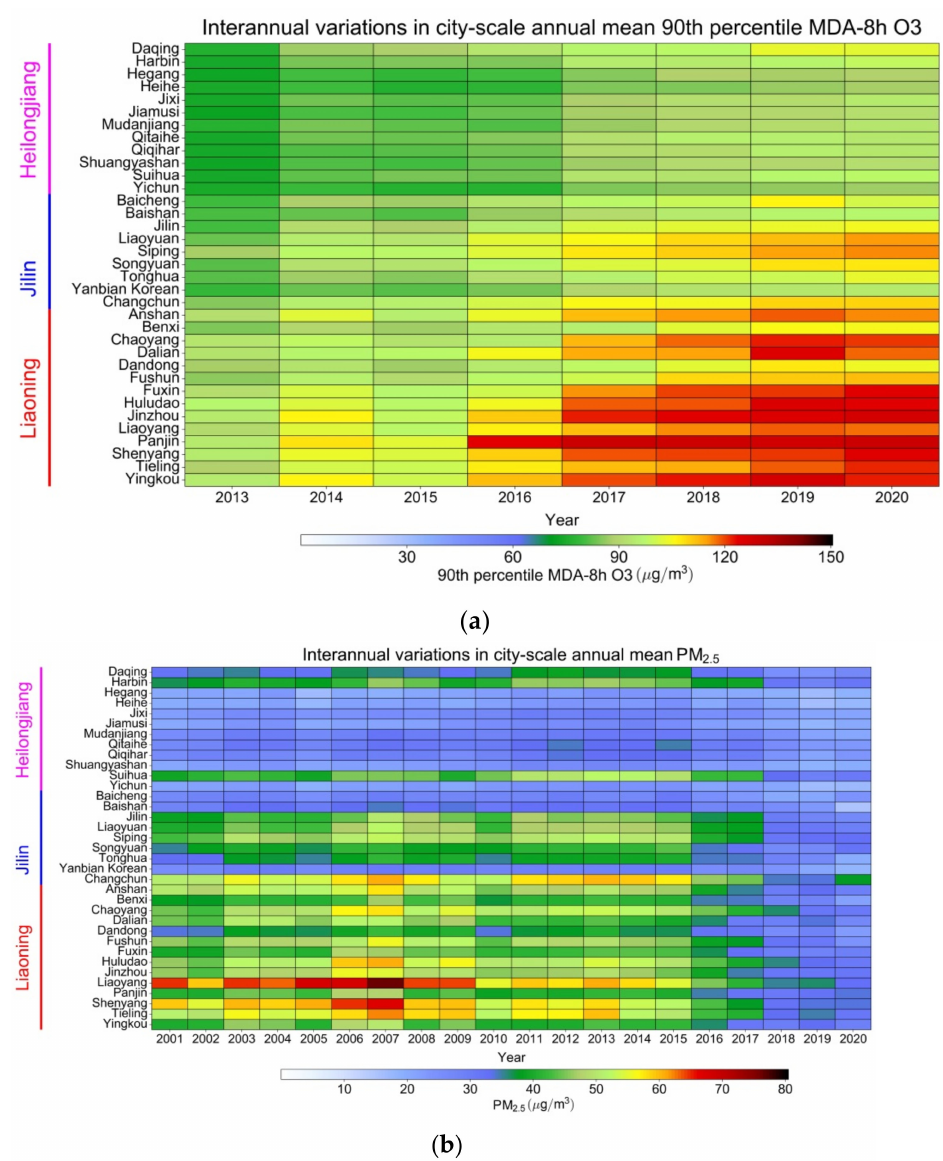
Figure 8. Interannual trends of ( a ) O 3 -8h-90per from 2013–2020 and ( b ) PM 2.5 from 2001–2020 in 35 cities of